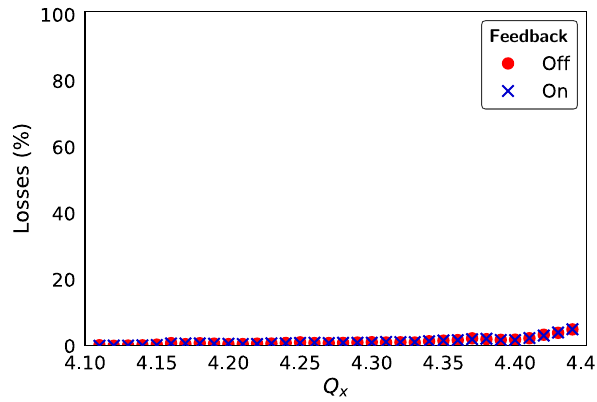
FIG. 17. Beam losses at 160 MeV versus horizontal tune with intensity N ¼ 3 × 10 12 p. Measurements with TFB off (red) and on (blue) are shown. With the temporarily modified kicker termination, no sign of the instability is observed even when the TFB is off, while severe beam losses were observed with the nominal operational configuration of the kicker [see Fig.